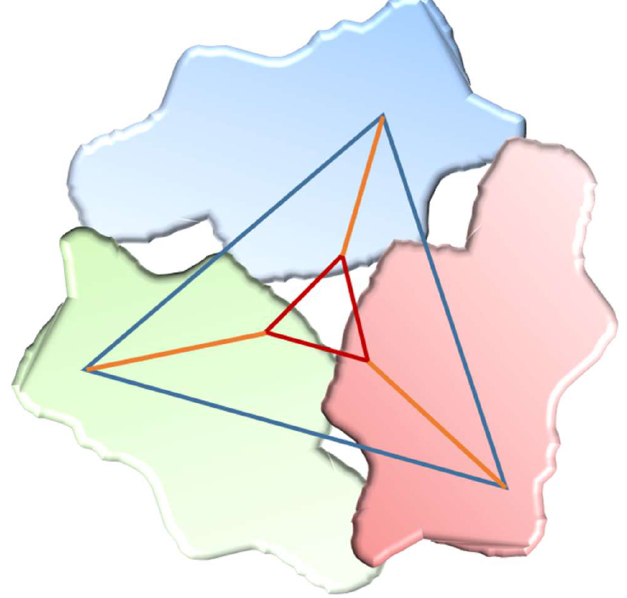
Figure 9. Representation of the hemagglutinin H5 trimer with distances highlighted between the binding sites.